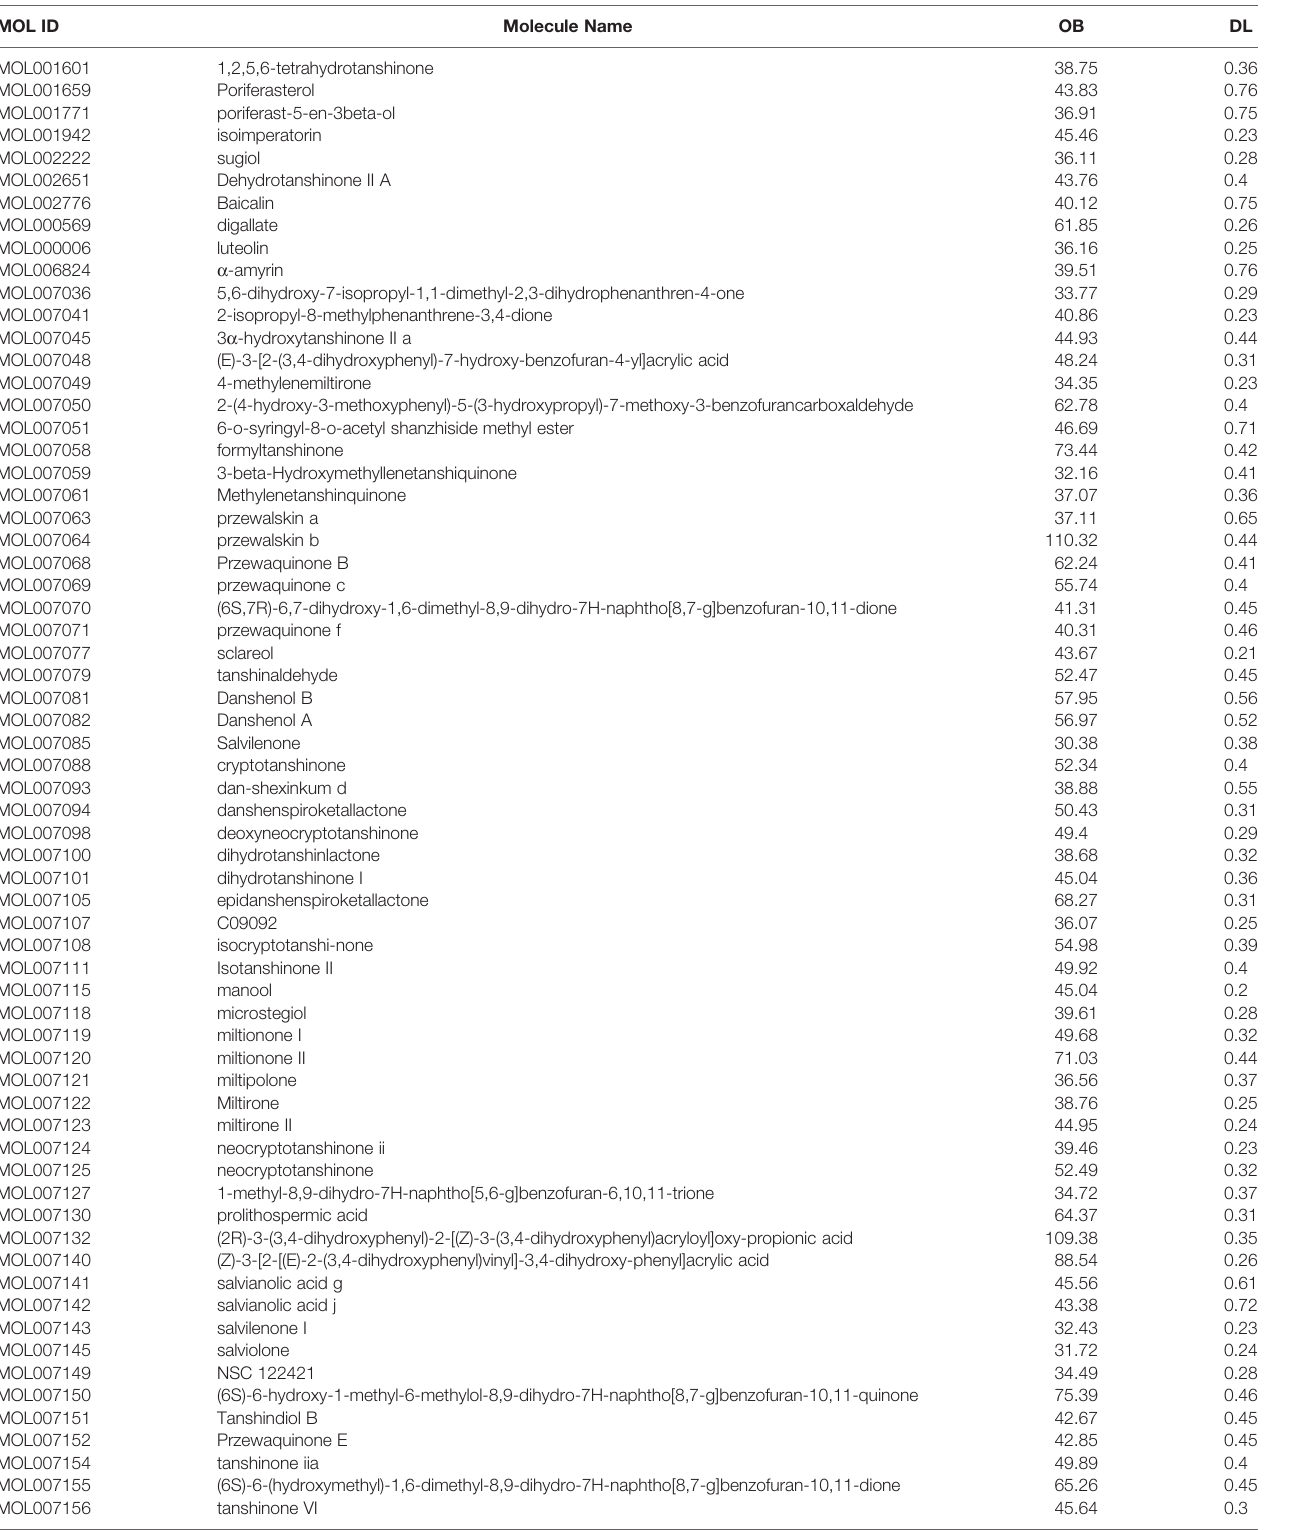
TABLE 1 | The information on the active ingredients of Salvia miltiorrhiza . MOL